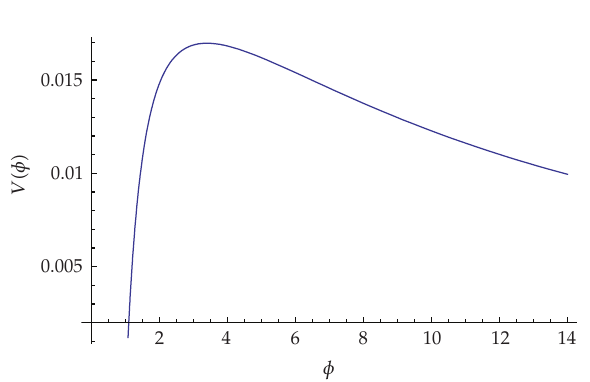
Figure 3: The form of the potential V (cid:3) φ (cid:6) has been plotted against φ (cid:3) with f (cid:2) 0 . 5 , h (cid:2) 0 . 68 , t 0 (cid:2) 13Gyr , Ω mo (cid:2) 0 . 3 (cid:6) . Early deceleration and late time acceleration are clearly distinguished by a cusp.